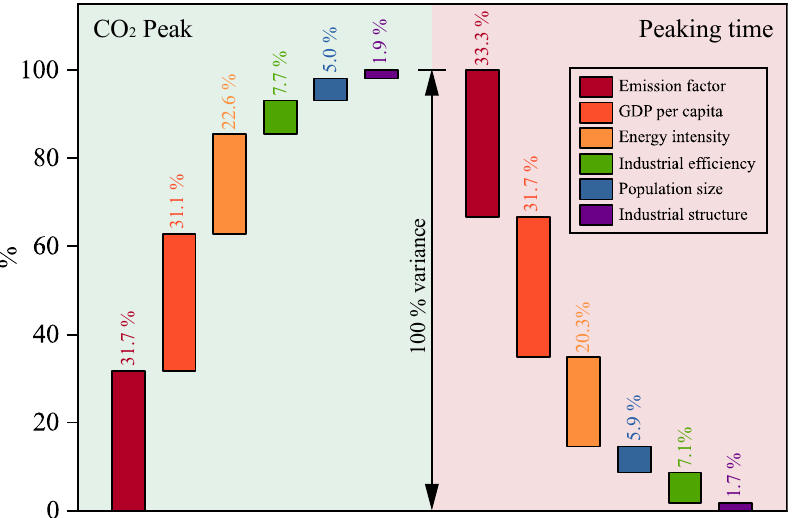
Figure 6. Sensitivity analysis of the uncertainty of carbon peak status of commercial building oper- ations.